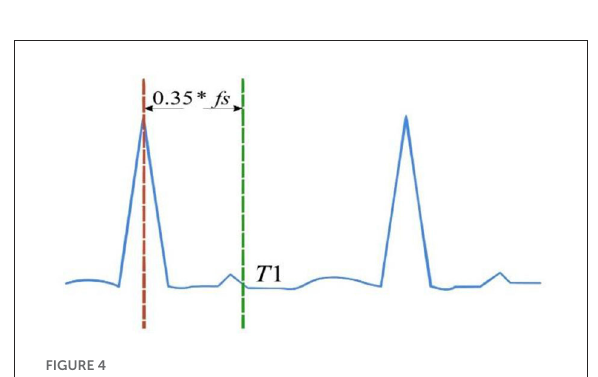
FIGURE4 Schematic diagram of selecting the starting point for the latter R